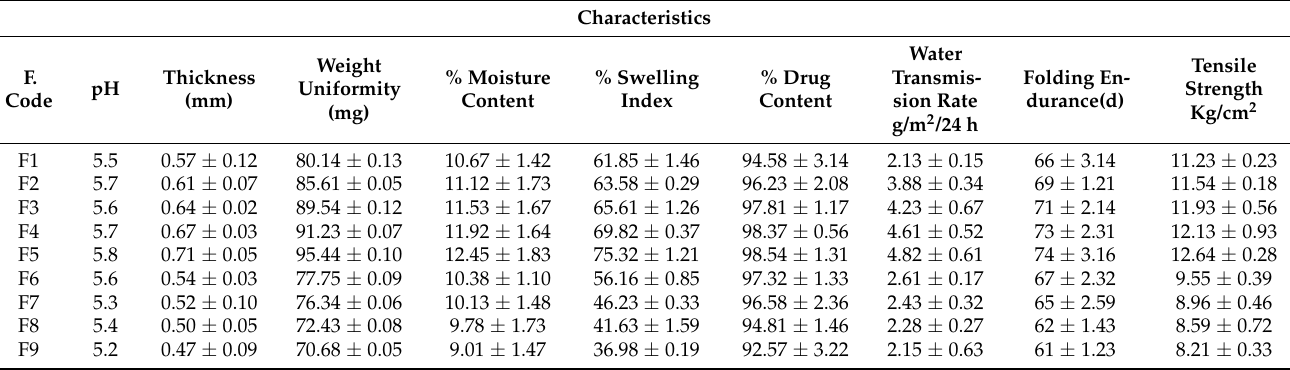
Table 2. Characterization of methotrexate